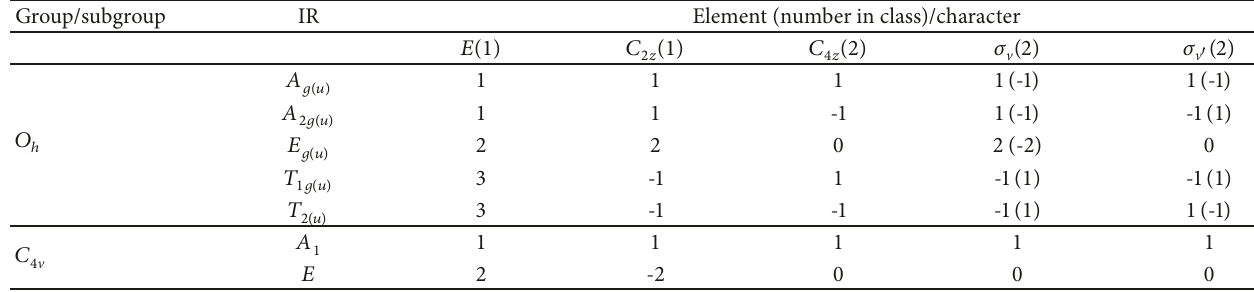
Table 2: Characters of group 𝑂 ℎ on its subgroup 𝐶 4 V (top part, characters of 𝑢 -IRs are shown in parenthesis, when they differ from 𝑔 -IRs) and characters of IRs 𝐴 1 and 𝐸 of group 𝐶 4 V . (bottom